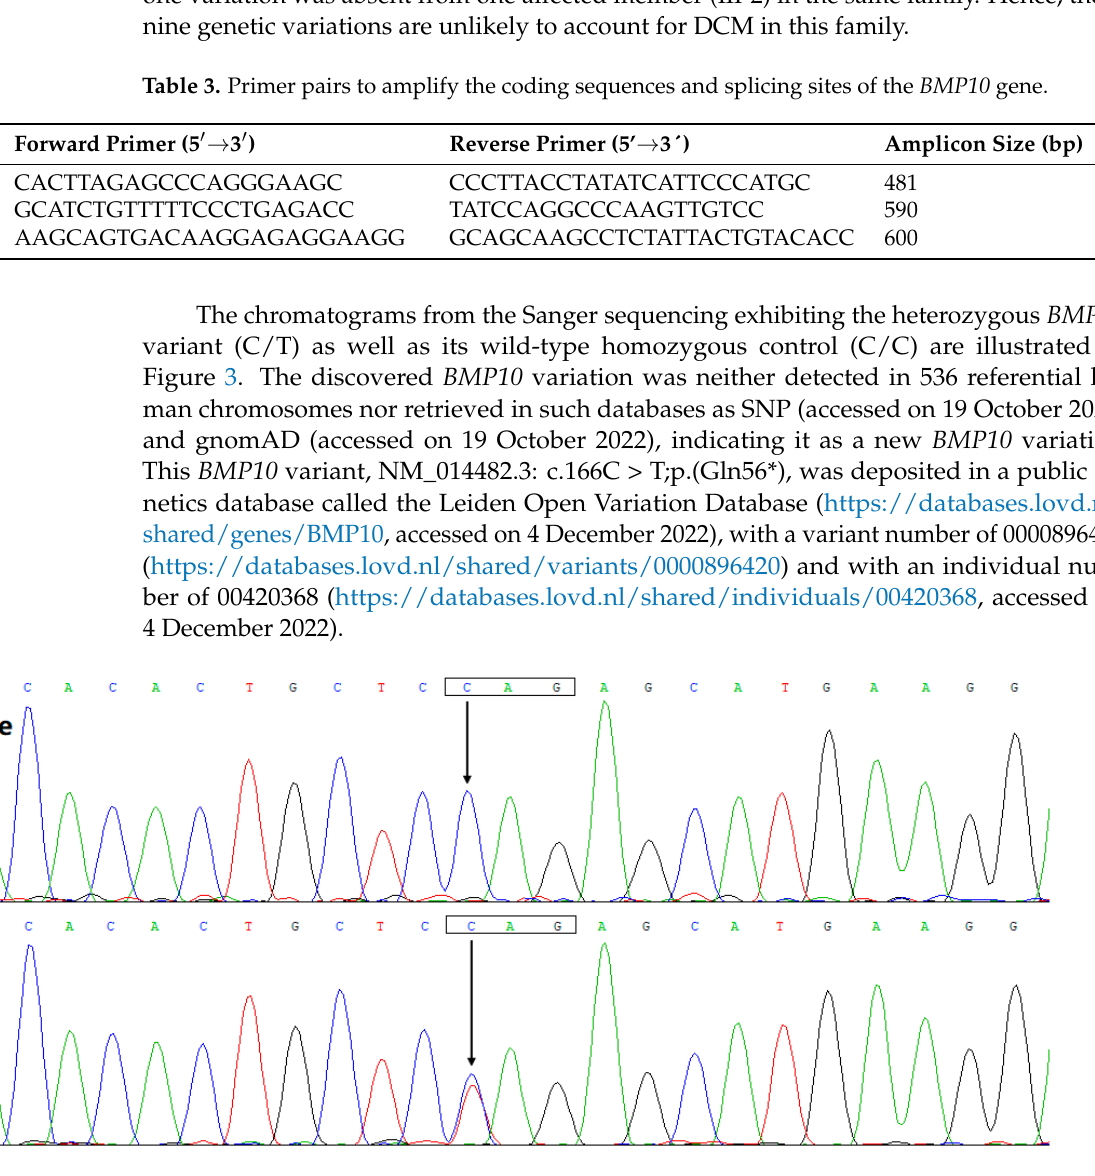
Figure 3. A new BMP10 variation responsible for dilated cardiomyopathy. The Sanger sequencing chromatograms confirmed the heterogeneous BMP10 variation (C/T) in the affected proband (mutant) in comparison with homozygous wild-type bases (C/C) in an unaffected individual (wild type). A rectangle delimits a codon. An arrow depicts the position where the variation occurs.